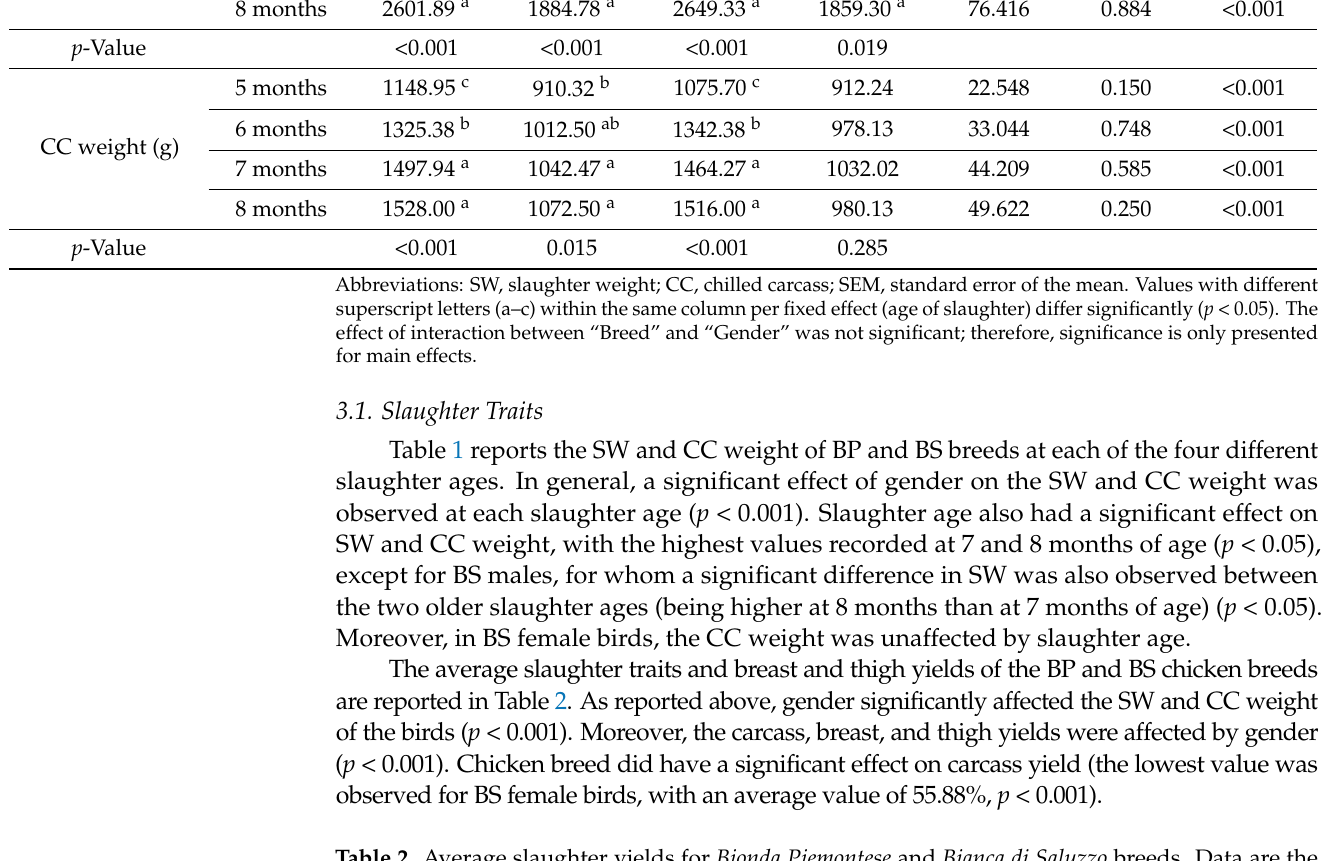
Table 2. Average slaughter yields for Bionda Piemontese and Bianca di Saluzzo breeds. Data are the average of the four consecutive slaughterings at 5, 6, 7, and 8 months of age ( n =